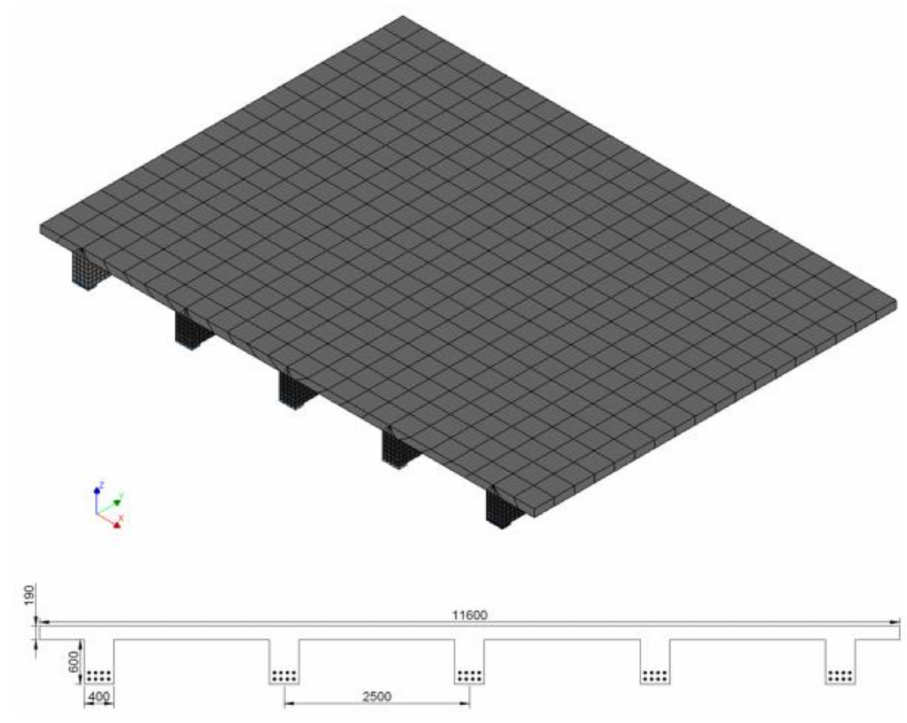
Figure 2. The superstructure of the bridge under investigation (dimensions in